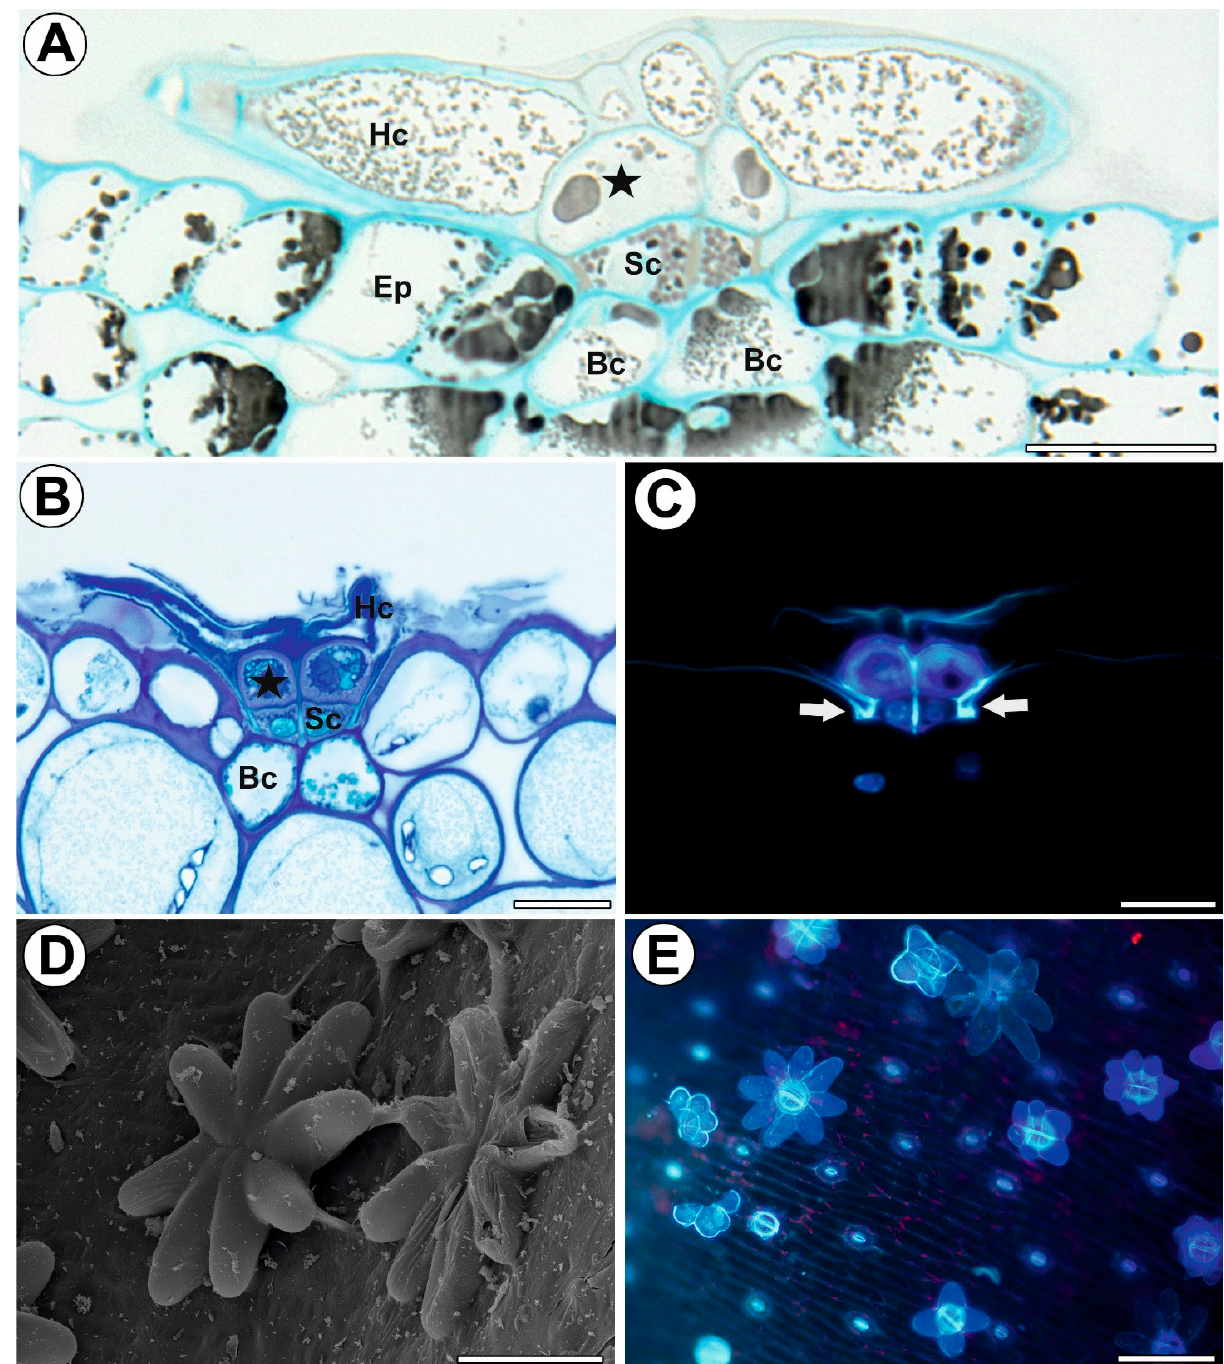
Figure 2. Structure of the stellate trichomes of the Dionaea muscipula traps. ( A , B ) A semi-thin section of a stellate trichome; outer head cell (Hc), internal head cell (star), stalk cell (Sc), basal cell (Bc) and an ordinary epidermal cell (Ep), bar 20 µm. ( C ) Section of a stellate trichome; autofluorescence of the cell walls, nuclei that had been treated with DAPI; note the strong autofluorescence of the cutinized cell walls (arrow), bar 20 µm. ( D ) Morphology of a stellate trichomes from a young trap, bar 50 µm. ( E ) Stellate trichomes with variable numbers of outer head cells from a young trap, bar 100 µm.